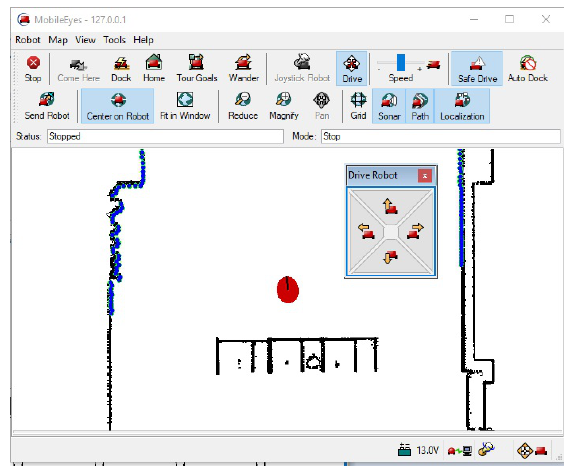
Figure 5. A zoomed view of MobileEyes GUI after a successful connection to the server showing the robot (red circle or icon in the middle of the map pane), its lidar data in blue colored points at the thickest lines in the pane, and the teleoperated window to drive the